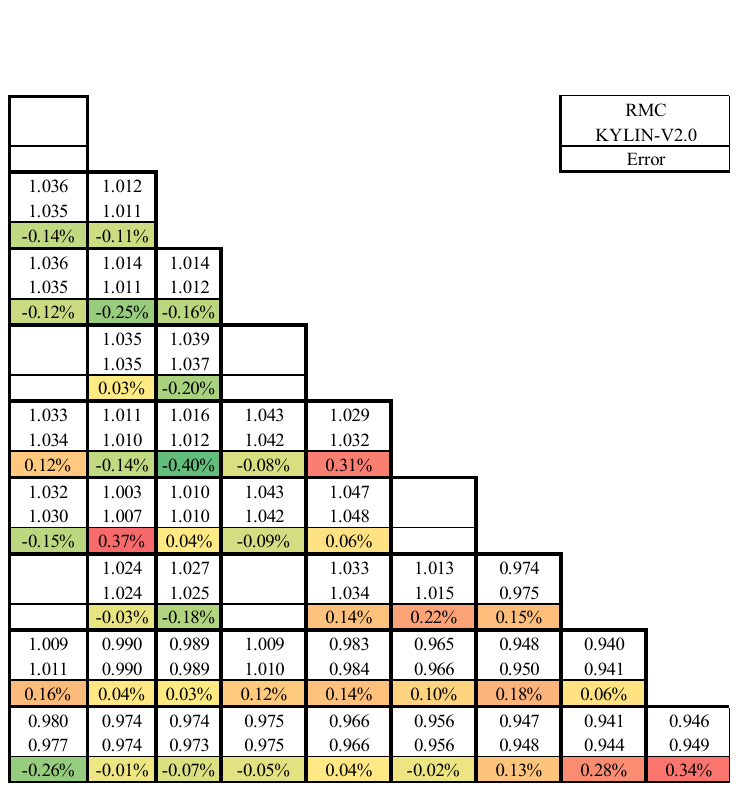
Figure 9. VERA 2B fuel assembly pin power distribution at 0 GWd/tU .